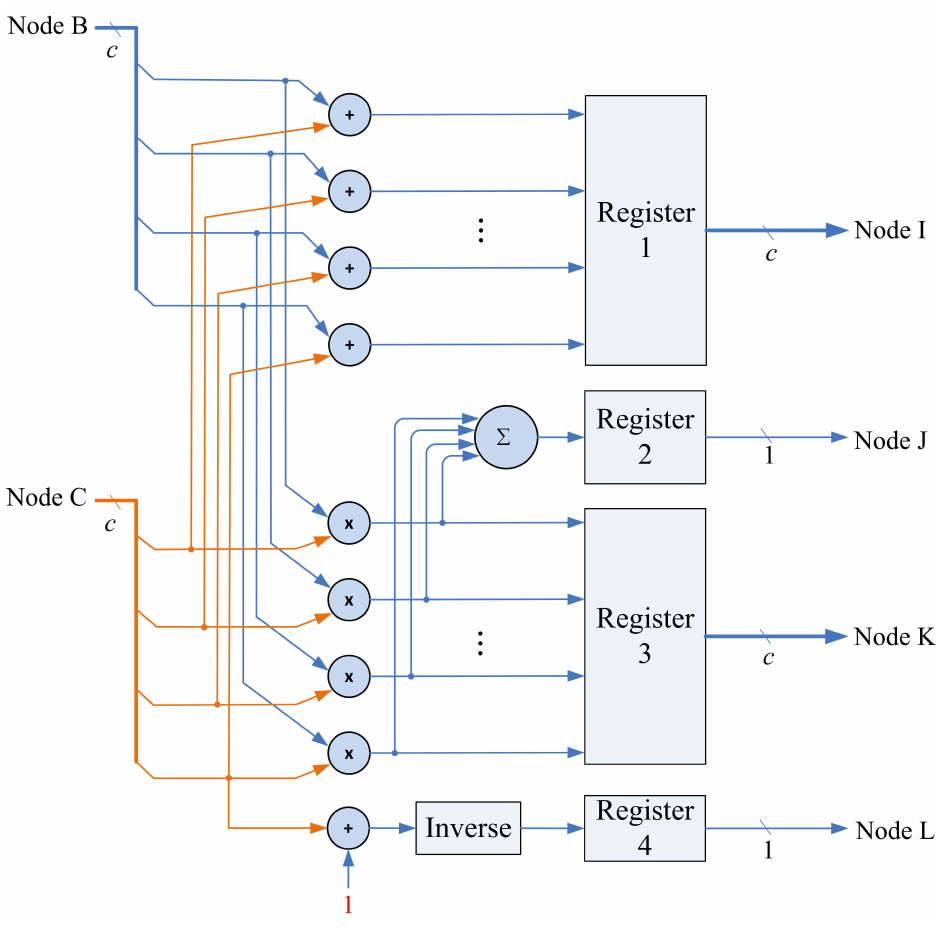
Figure 11. The architecture of matrix computation unit.